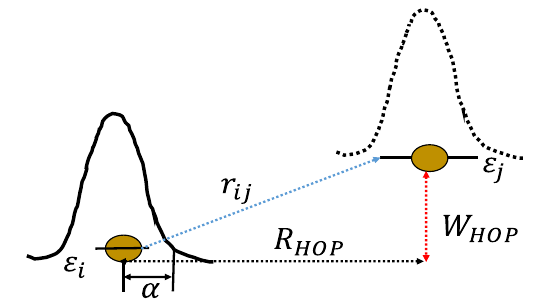
gas (93%) to form plasma ions that bombard the Ge